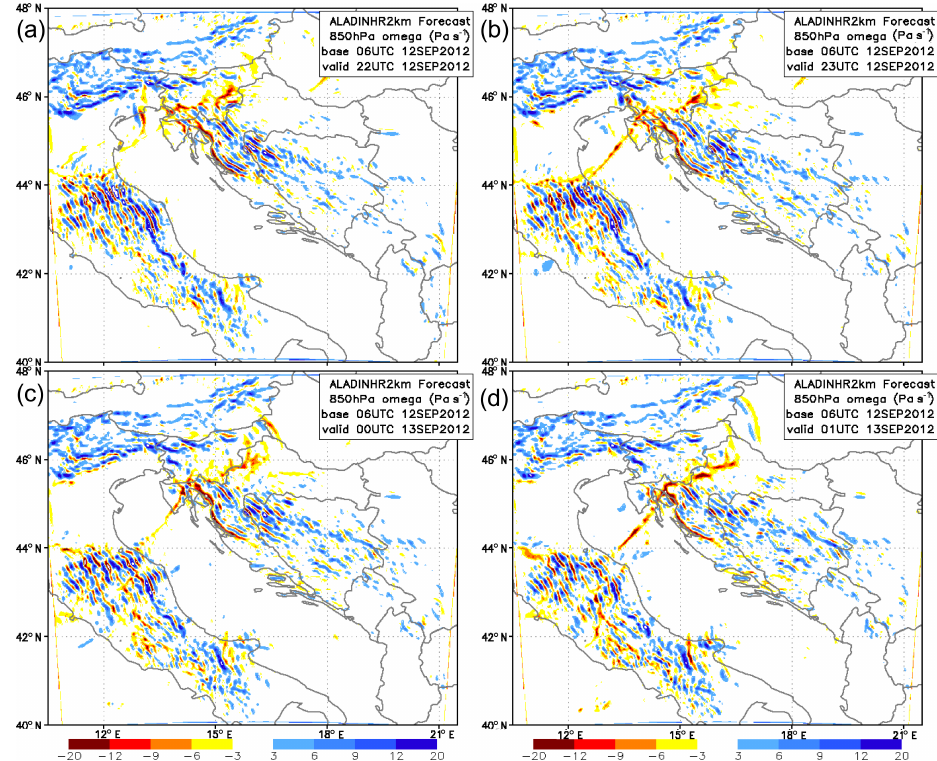
Figure 15. Vertical velocity omega (Pas − 1 ) at the 850hPa level from the operational 2km-resolution forecast for (a) 22:00 and (b) 23:00 UTC on 12 September and (c) 00:00 and (d) 01:00UTC on 13 September 2012; upward motions are shown in shades of red, and downward motions are shown in blue.